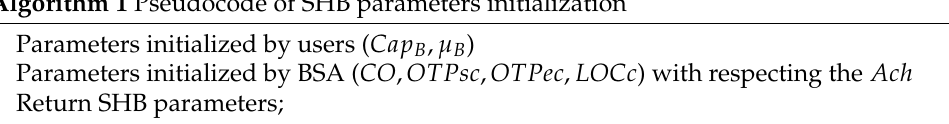
Algorithm 1 Pseudocode of SHB parameters initialization